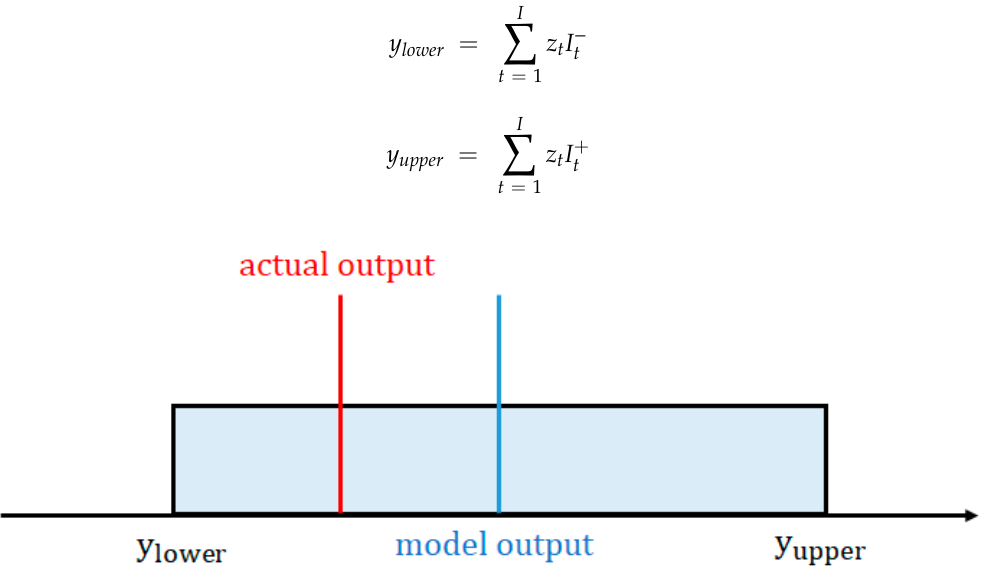
Figure 4. The model output and actual output of interval-based GM.